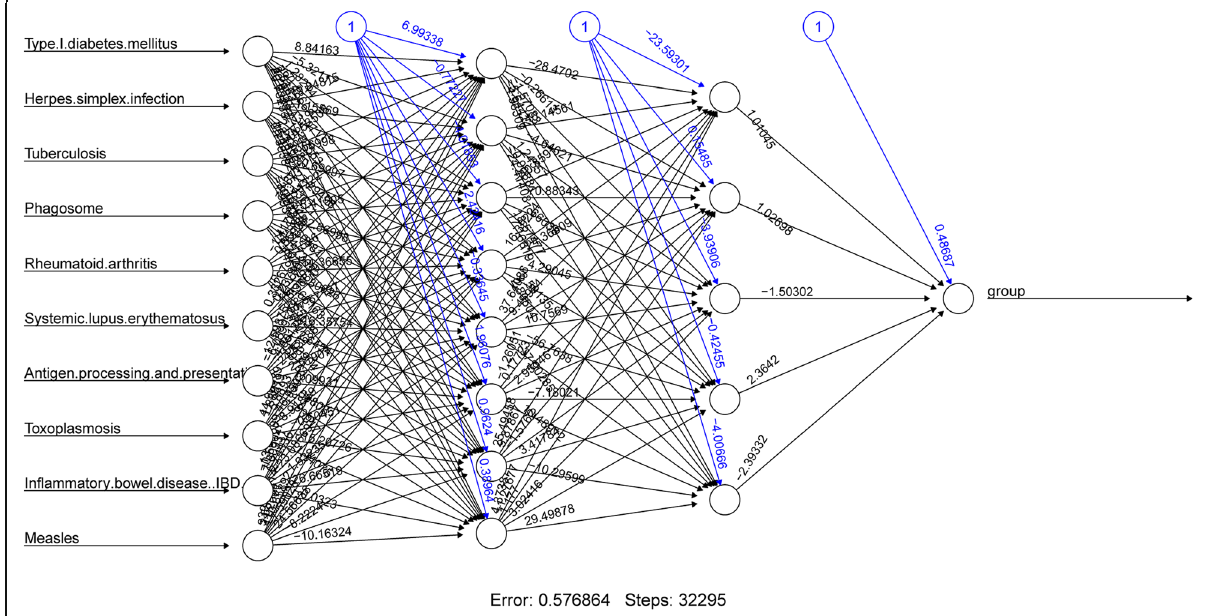
Fig. 4 Artificial neural network (ANN) based on 10 significant pathways, consisting of an input layer, two hidden layers, and an output layer, corresponding to 15, 8, 5, and 1 neuron, respectively. The circles represent neurons, while the lines between the circles represent connections. The black lines represent the connections between the neurons, while the blue lines represent the weights